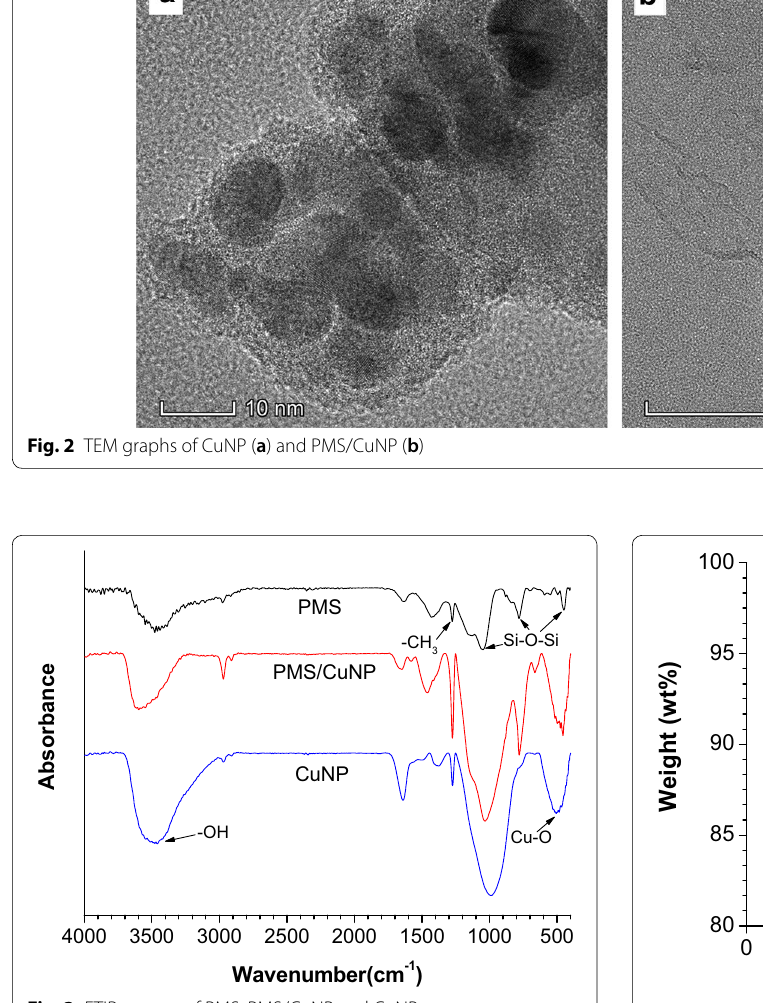
Fig. 3 FTIR spectra of PMS, PMS/CuNP and CuNP